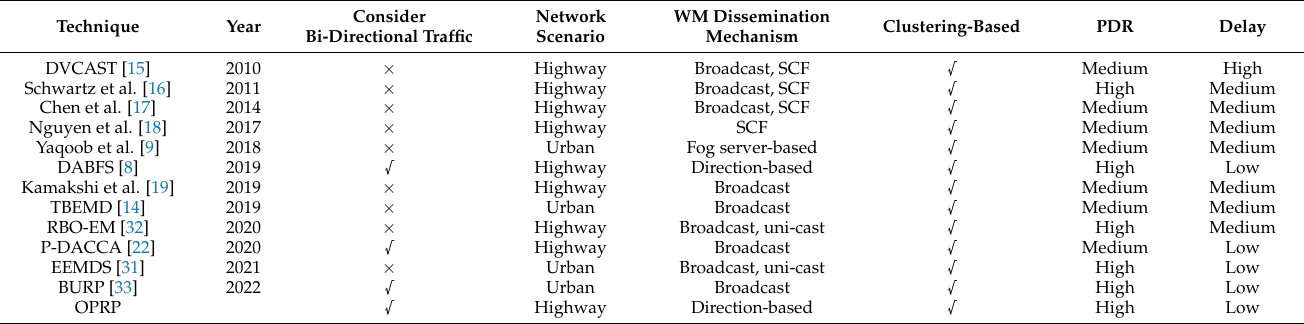
Table 1. Comparison of VANET WM dissemination